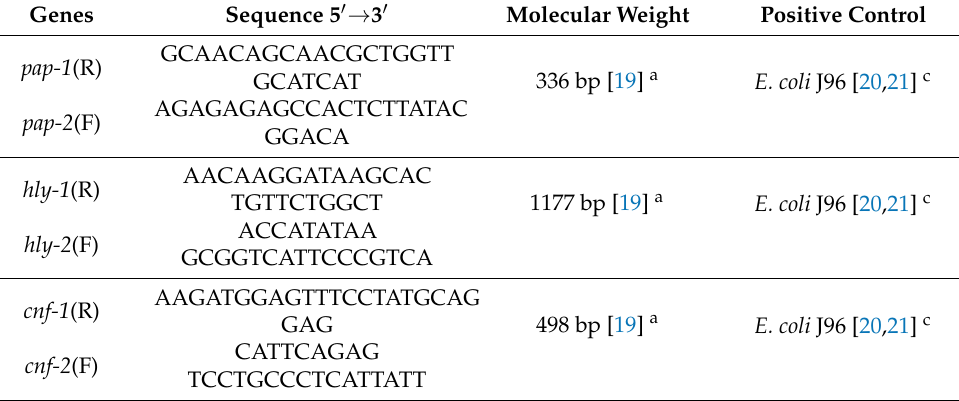
Table 1. Primers for identification of virulence genes pap , hly , cnf , sfa , and afa in Escherichia coli .